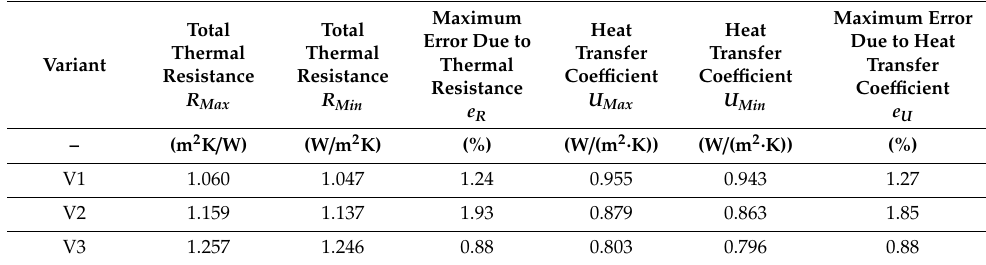
Table 7. Maximum and minimum values obtained with three methods and relative errors resulting from these